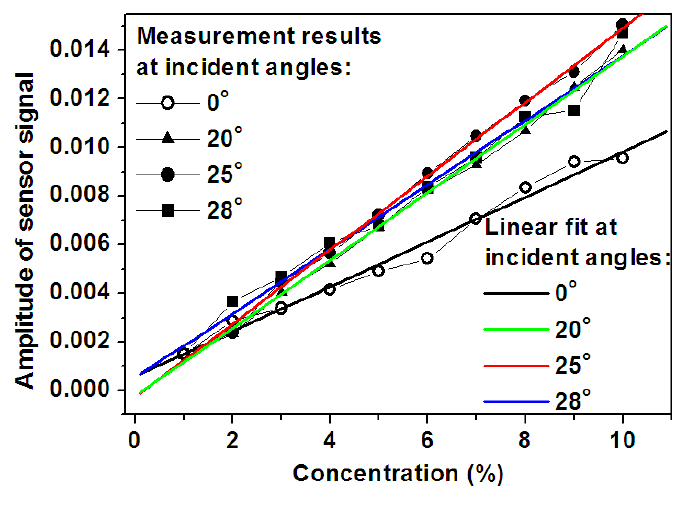
Figure 14. Amplitude of the sensor signal as a function of the concentration of the glucose solution at incident angles of 0, 20, 25 and 28 degrees. The solid lines show the corresponding linear fit to the measurement